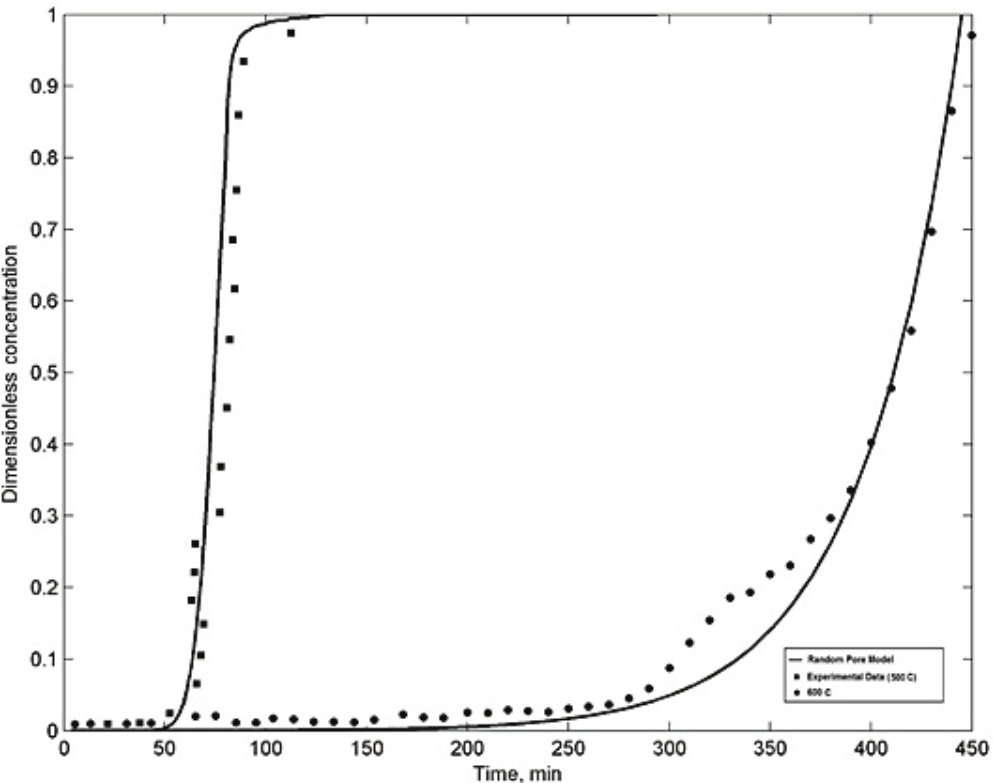
Fig. 6 – Comparison between random pore model predictions and experimental SO at 1 vol.%